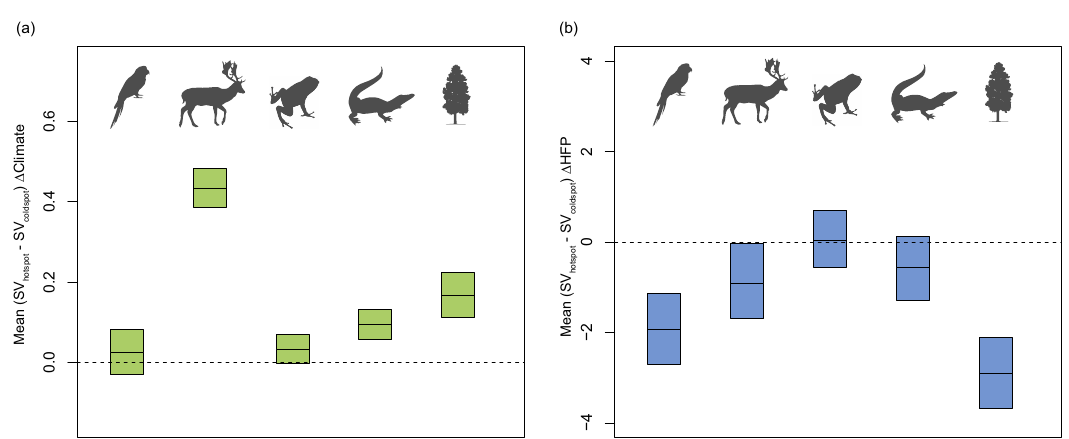
Fig. 5 Difference in climate change ( Δ Climate) and human footprint change ( Δ HFP) between species vulnerability (SV) hotspots and coldspots of respective groups. a difference in climate change between species vulnerability hotspots and coldspots and b difference in human footprint change between species vulnerability hotspots and coldspots. Central solid lines indicate mean differences between a random hotspot point and a random coldspot point and the upper and lower bounds represent 90% con fi dence interval calculated with 1000 bootstrap